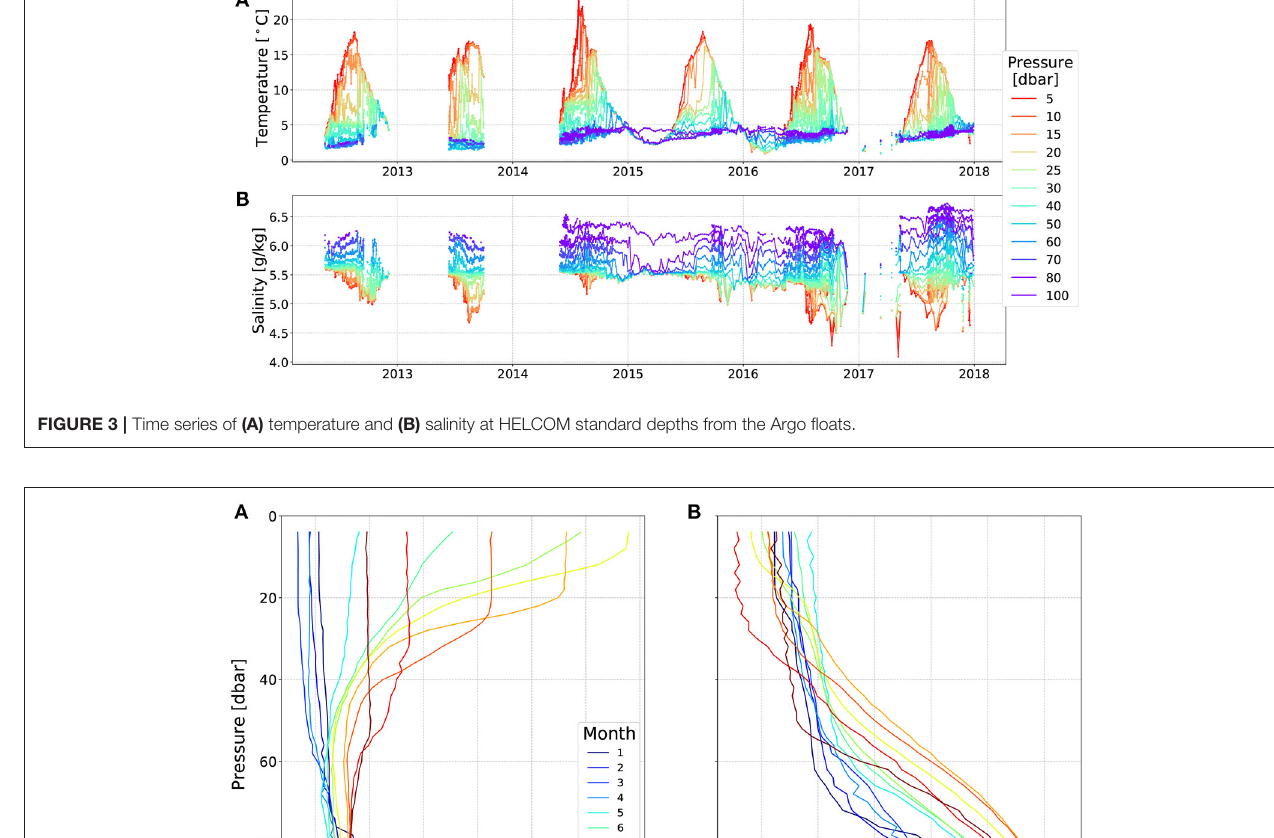
Measured salinity range close to surface was from 4.18 g kg − 1 (5.5.2017, float 6902023) to 5.74 g kg − 1 (2.6.2012, float 6901901) ( Figure 3B ). For 100 dbar depth the minimum and